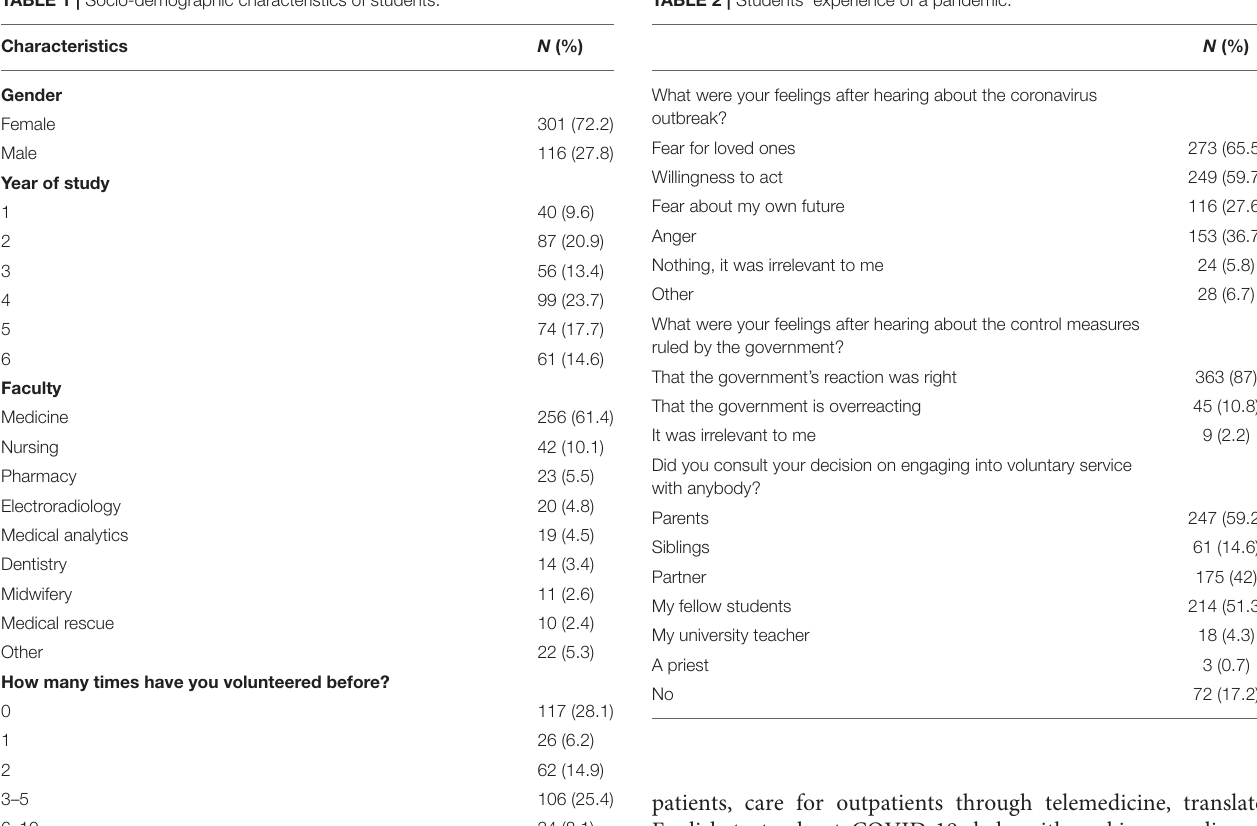
TABLE 1 | Socio-demographic characteristics of students. TABLE 2 | Students’ experience of a